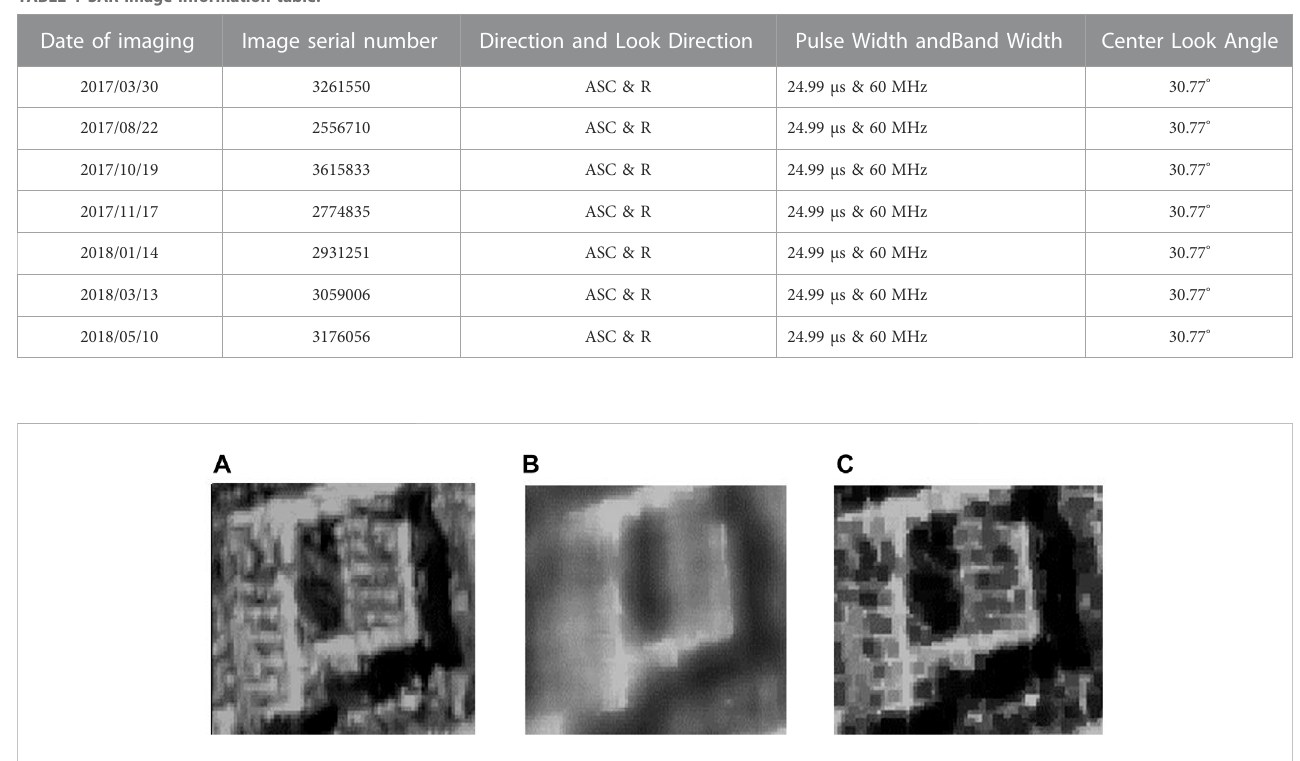
FIGURE 3 (A) Original image. (B) NLG algorithm denoising image without considering the number of pixels. (C) NLG algorithm denoising image considering the number of